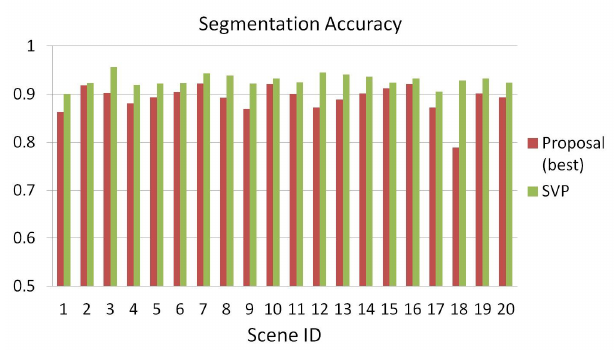
Figure 7: Segmentation accuracy and comparison with the object segment proposals of Endres and Hoiem